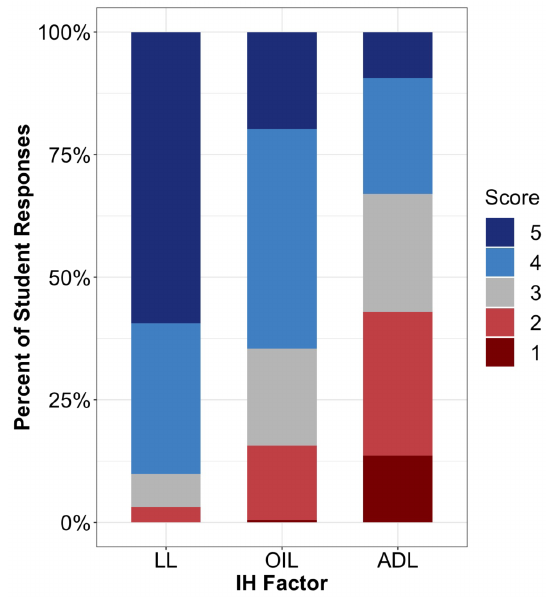
FIG. 2. Stacked bar charts displaying the distributions of survey responses for each IH factor. The height of each bar segment represents the percentage of student responses of that Likert value. For all statements, 5 is the most favorable response and 1 is the least favorable response from the limitations-owning defi- nition of